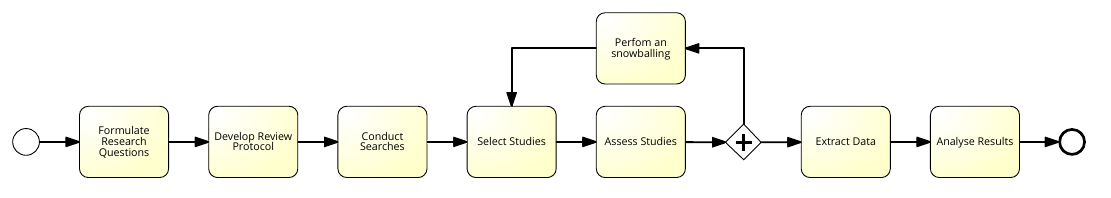
Figure 1. Phases of the systematic literature